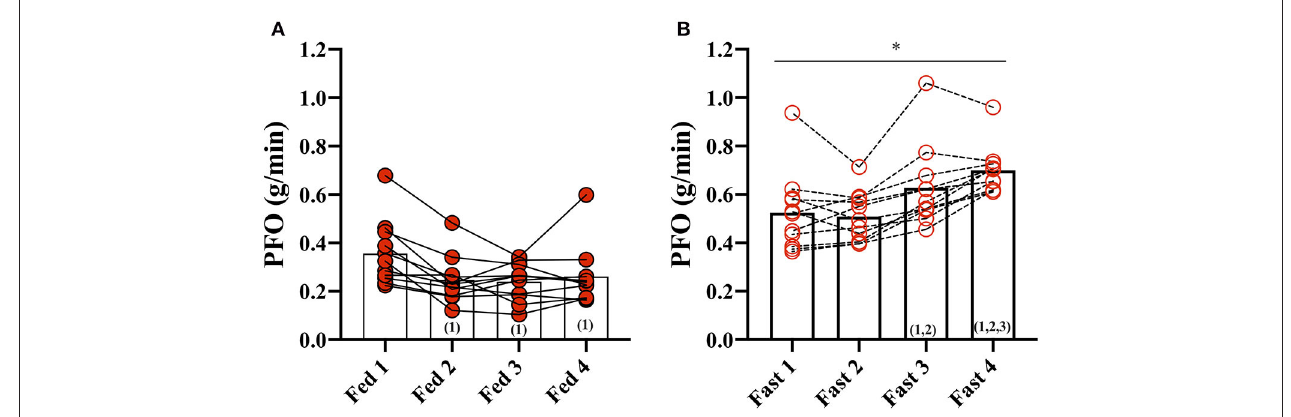
FIGURE 1 | Peak fat oxidation (PFO) during exercise in the fasted and fed state. (A) PFO (g/min) during GXT: Fed 1, 2, 3, and 4 and (B) during GXT Fast 1, 2, 3, and 4. * represents the significant difference between conditions (Fed vs. Fast) within the same test number (e.g., GXT 1 vs. 2) and (number) represents the statistical difference from GXT